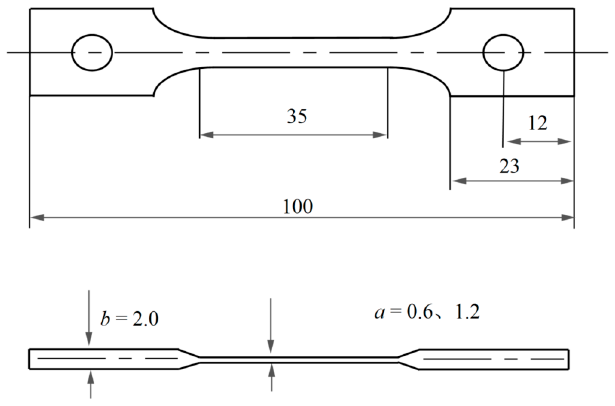
Figure 3. Geometry of the present thin-walled creep specimen.